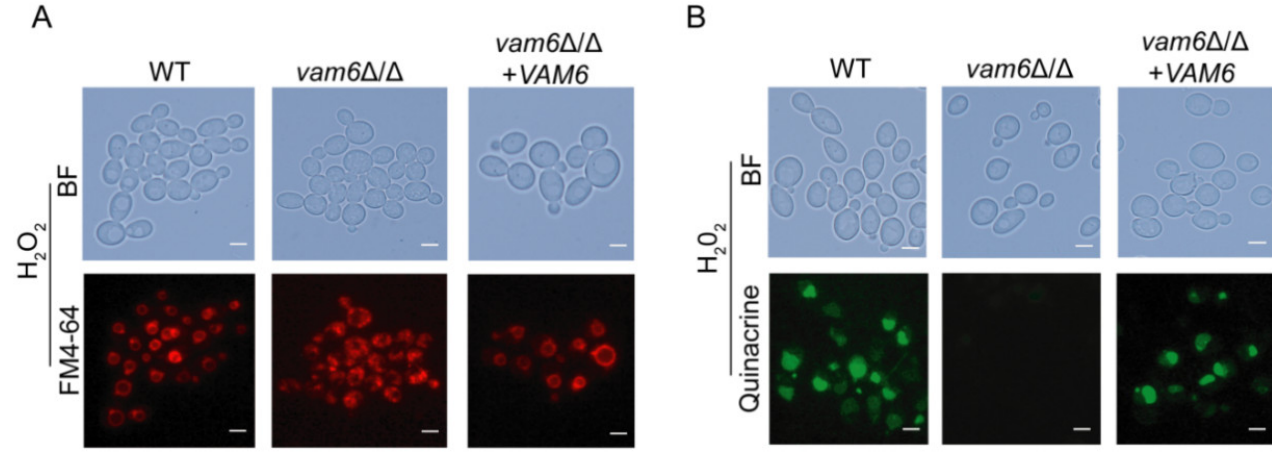
Figure 3. Deletion of VAM6 has an impact on vacuolar morphology and function. ( A ) Vacuolar morphology of the strains revealed by FM4-64 staining. Vacuolar morphology was observed by a fluorescence microscopy after FM4-64 staining. Bar = 5 μm. ( B ) Vacuolar pH under oxidative stress revealed by Quinacrine staining. Bar = 5 μm.